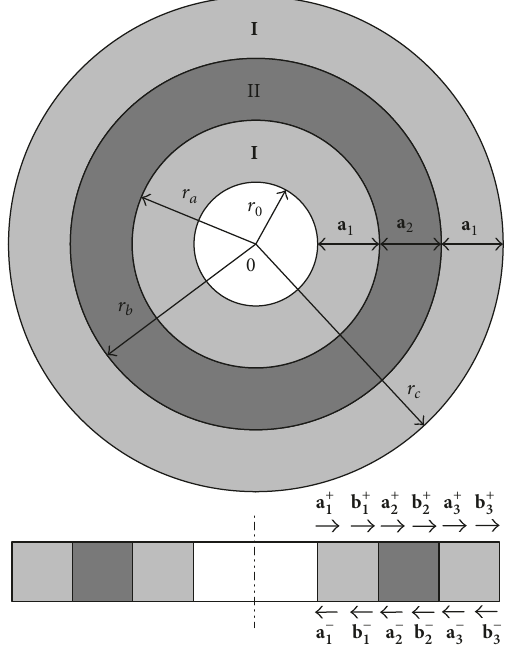
Figure 1: Composite